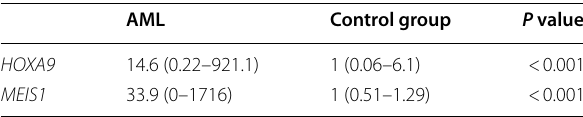
Table 2 Expression levels of the assessed genes in the patients’ groups